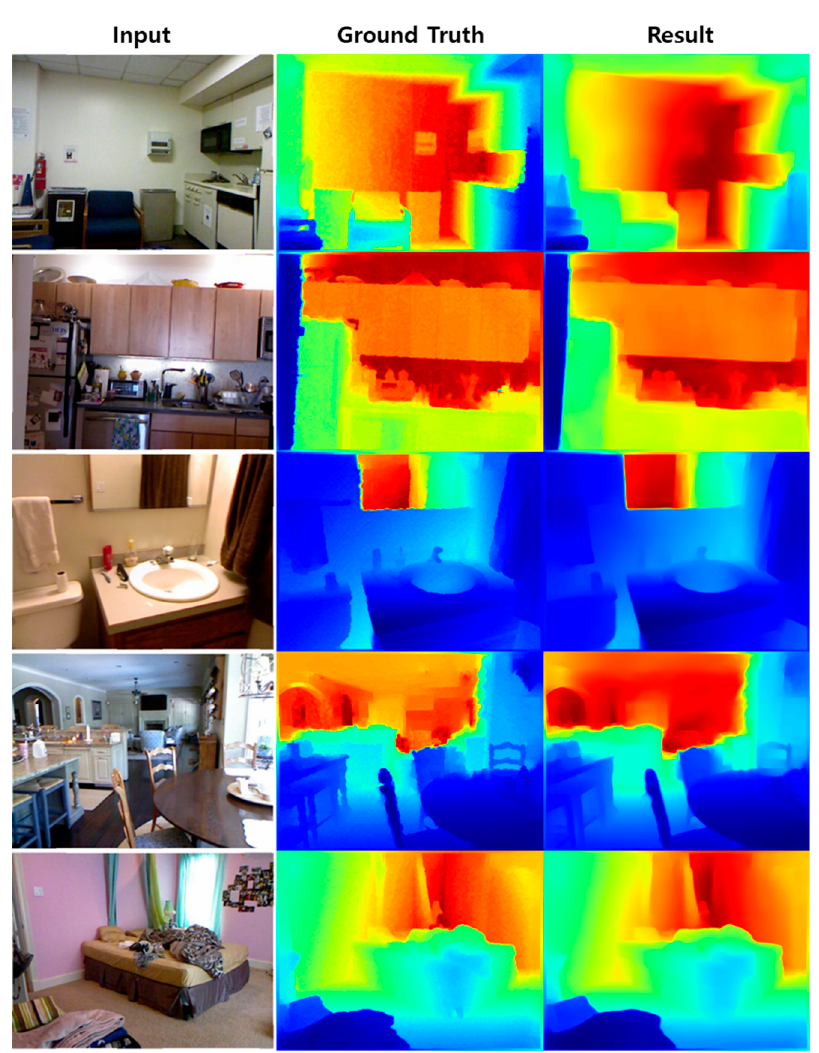
Figure 15. Depth estimation results of the images of NYU Depth Dataset V2.